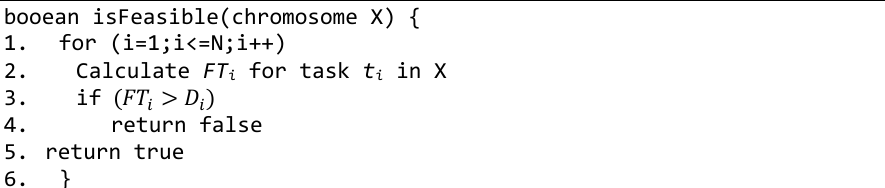
Figure 3. Pseudo ‐ code to check the feasibility of a solution.